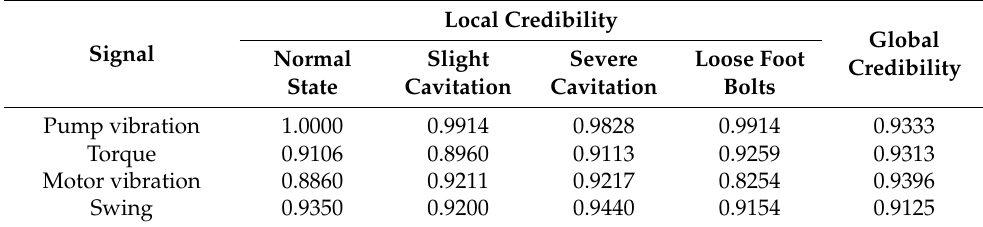
Table 2. Classification credibility of BP neural